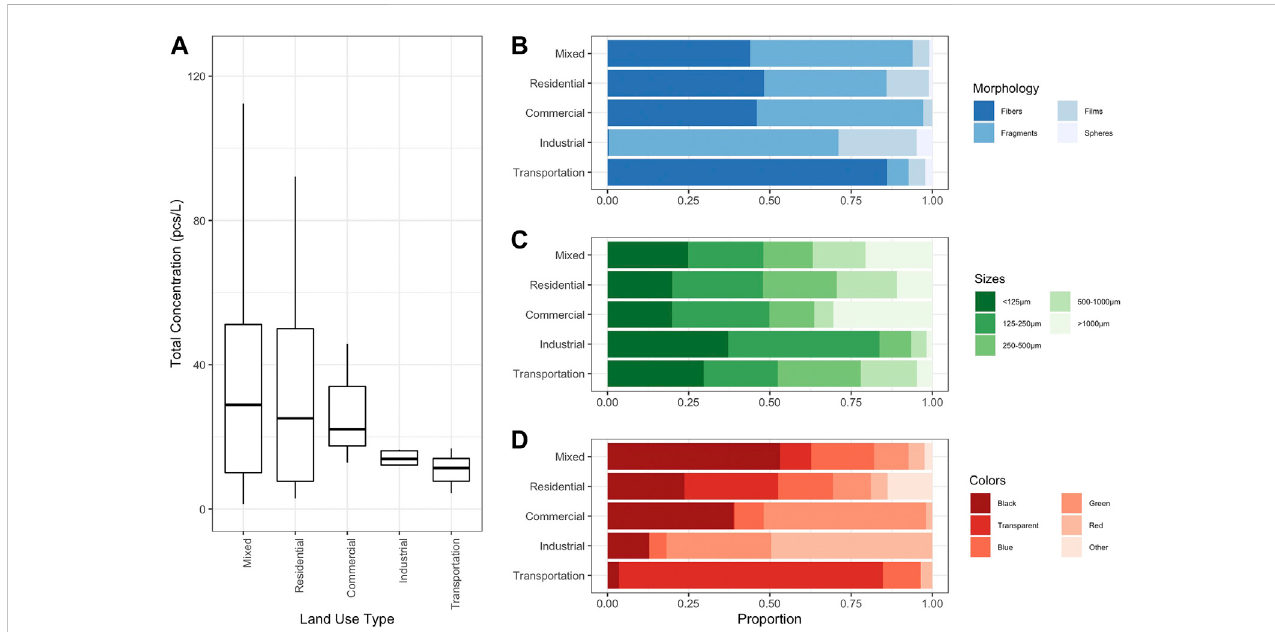
FIGURE 4 (A) Boxplot of microplastic concentrations in stormwater collected from catchments of differing predominant land use. Right side shows average percent composition of microplastics in different morphological categories (B) , size classes (C) , and colors (D) in stormwater collected from catchments of differing land use